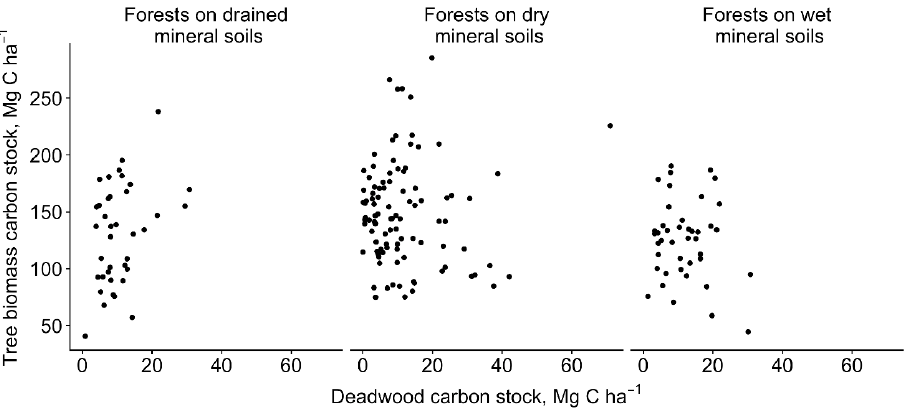
Figure 3. The tree biomass and deadwood carbon stocks of sample plots in different forest site types.